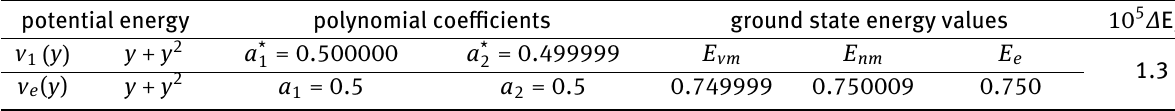
Table 1: Physical parameters for the potential energy v 1 ( y ) = y + y 2